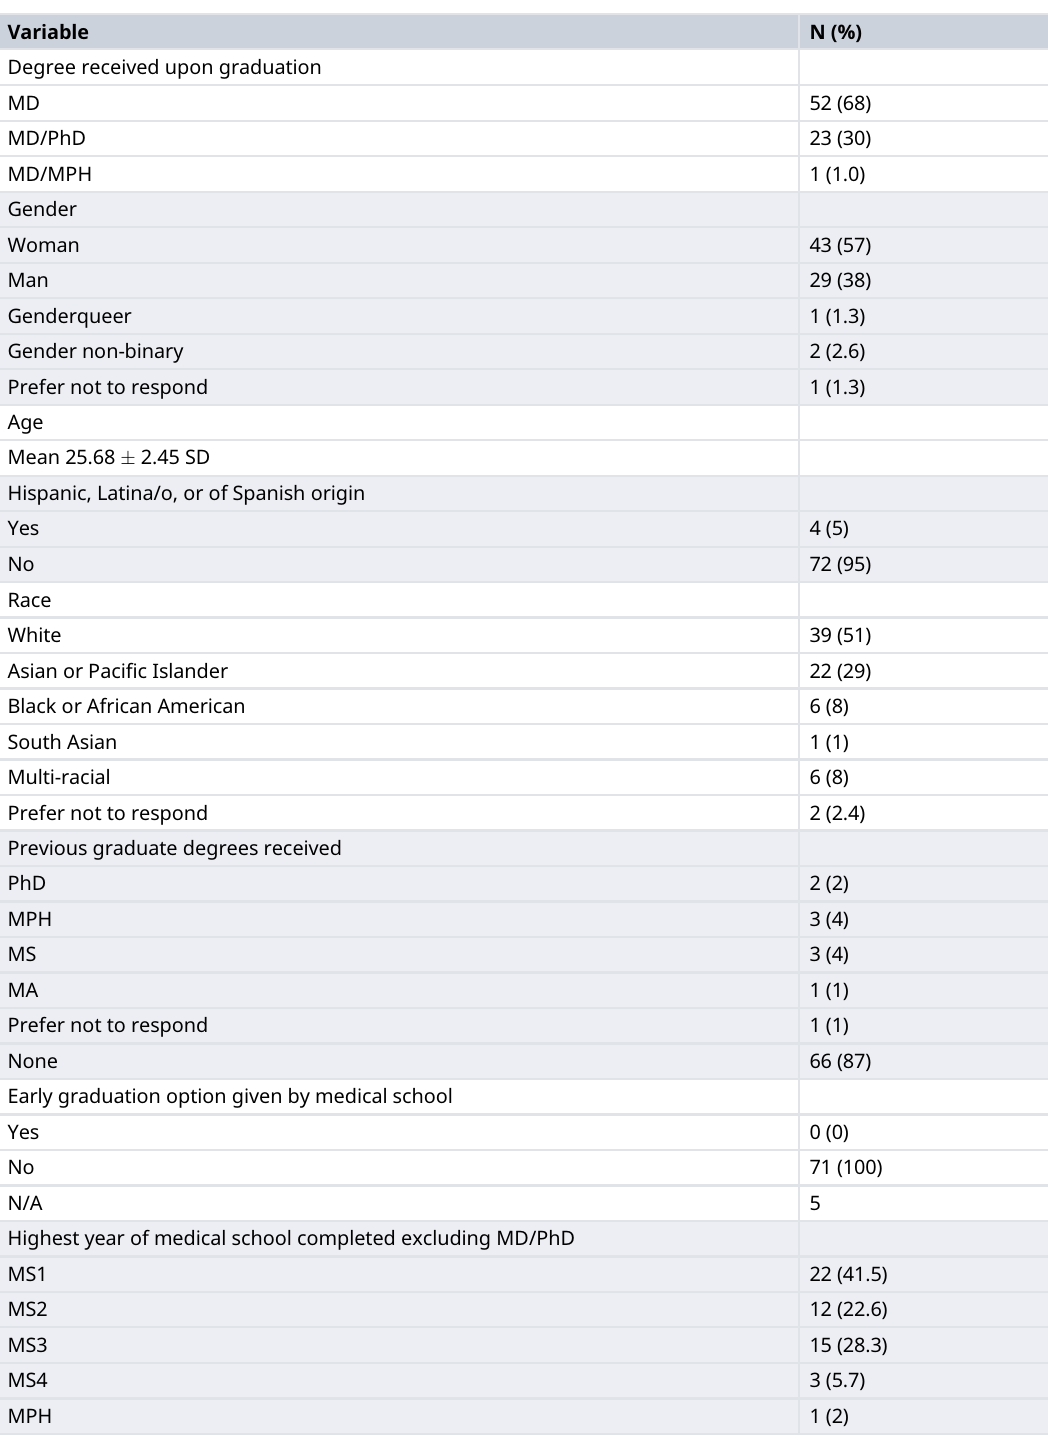
Table 1. Characteristics of respondents to the COVID-19 medical student